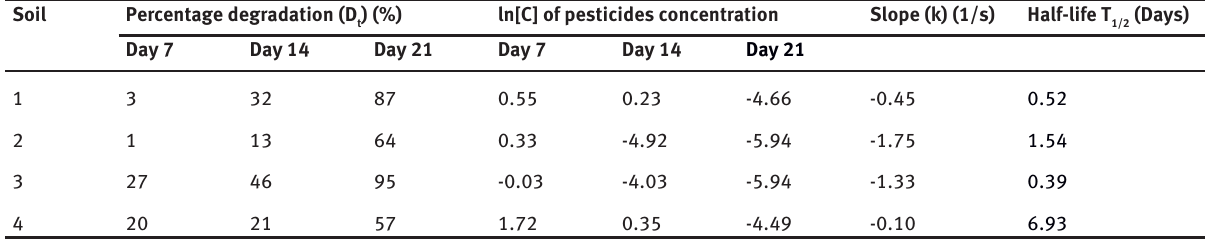
Table 2: Biodegradation of Bensulfuron-methyl by Aspergillus niger. Soil